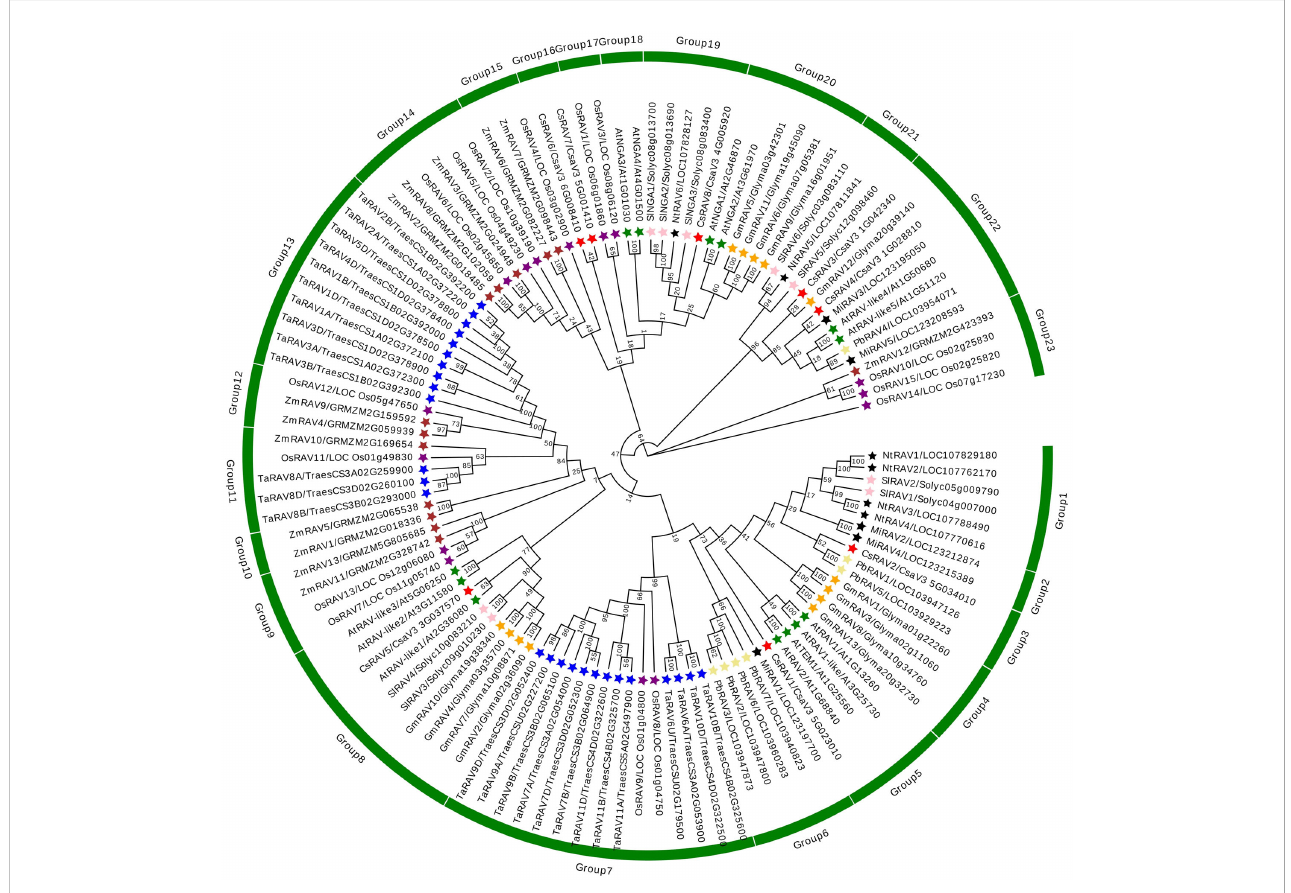
FIGURE 1 Phylogenetic relationships of 115 RAV proteins from Cucumis sativus , Arabidopsis thaliana , Solanum lycopersicum, Glycine max, Oryza sativa, Triticum aestivum, Zea mays, Mangifera indica, Pyrus bretschneideri and Nicotiana tabacum . The MEGA 7.0 software was used to construct the phylogenetic tree of 115 RAVs with complete amino acid sequences. The CsRAV proteins were marked with red